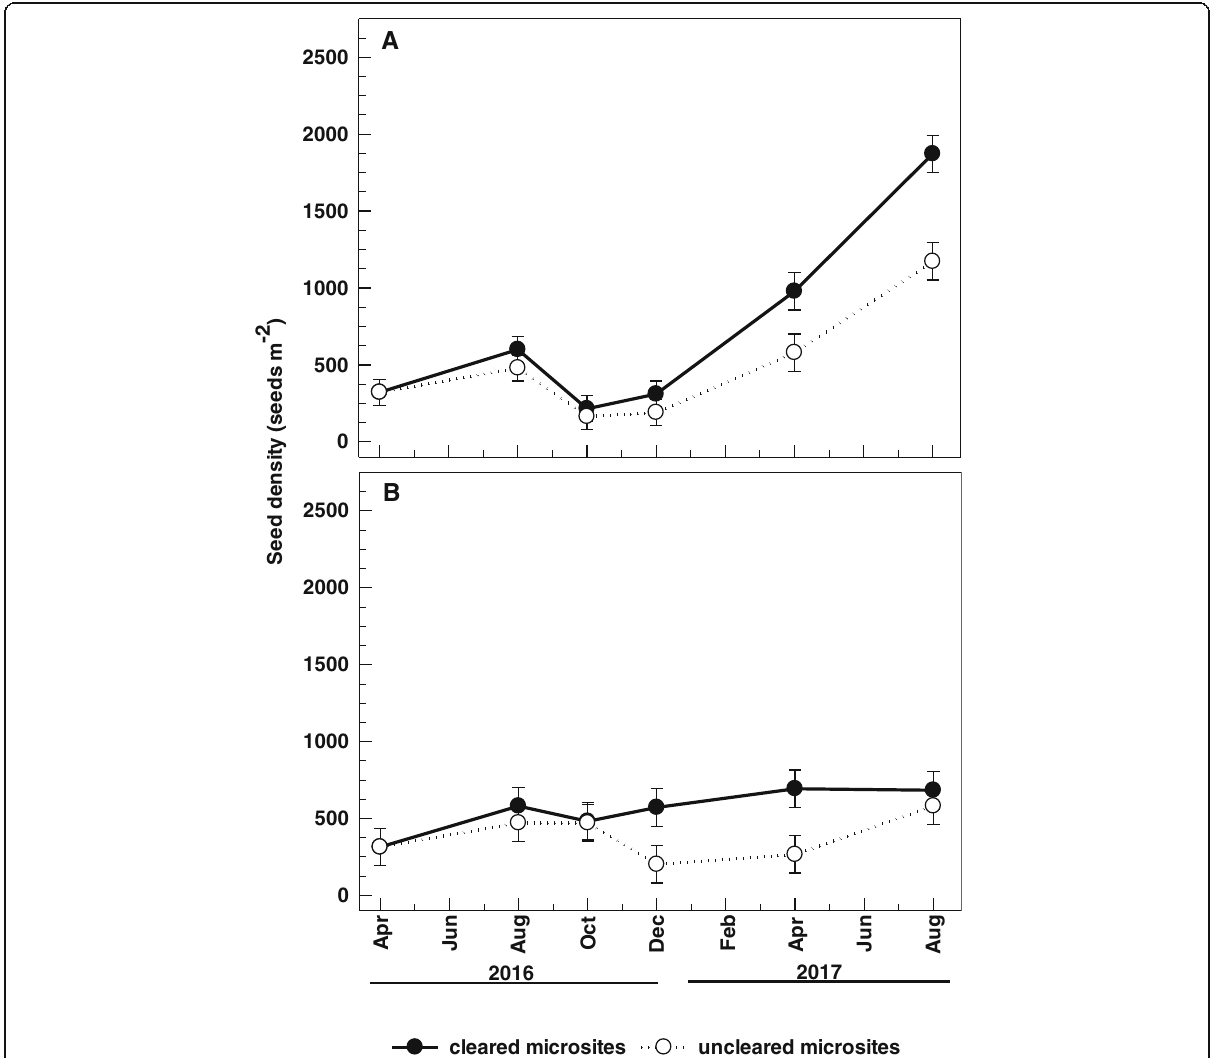
Fig. 1 Total seed density in cleared and uncleared microsites at Maseding ( a ) and Kgomokgomo ( b ) rangelands from April 2016 to August 2017. The presented data are back-transformed means and error bars represent ± standard error of